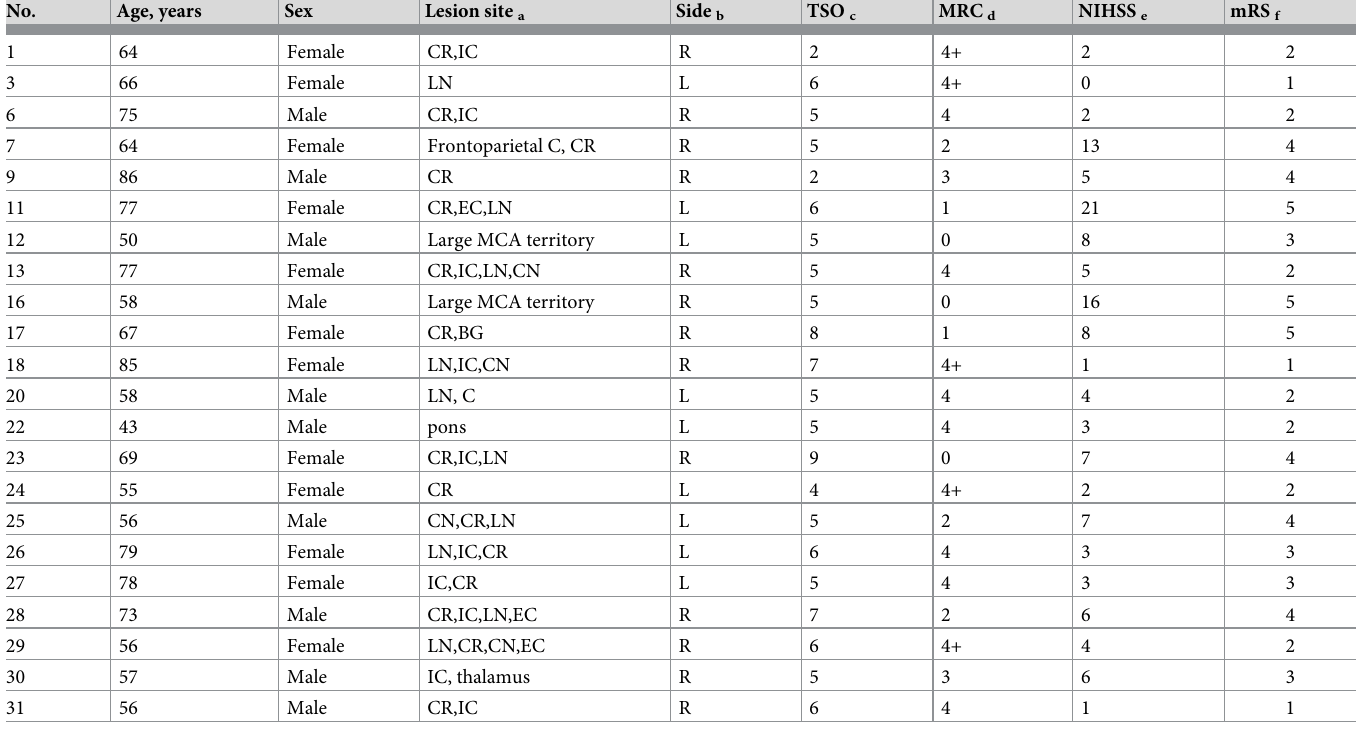
Table 1. Demographic and clinical